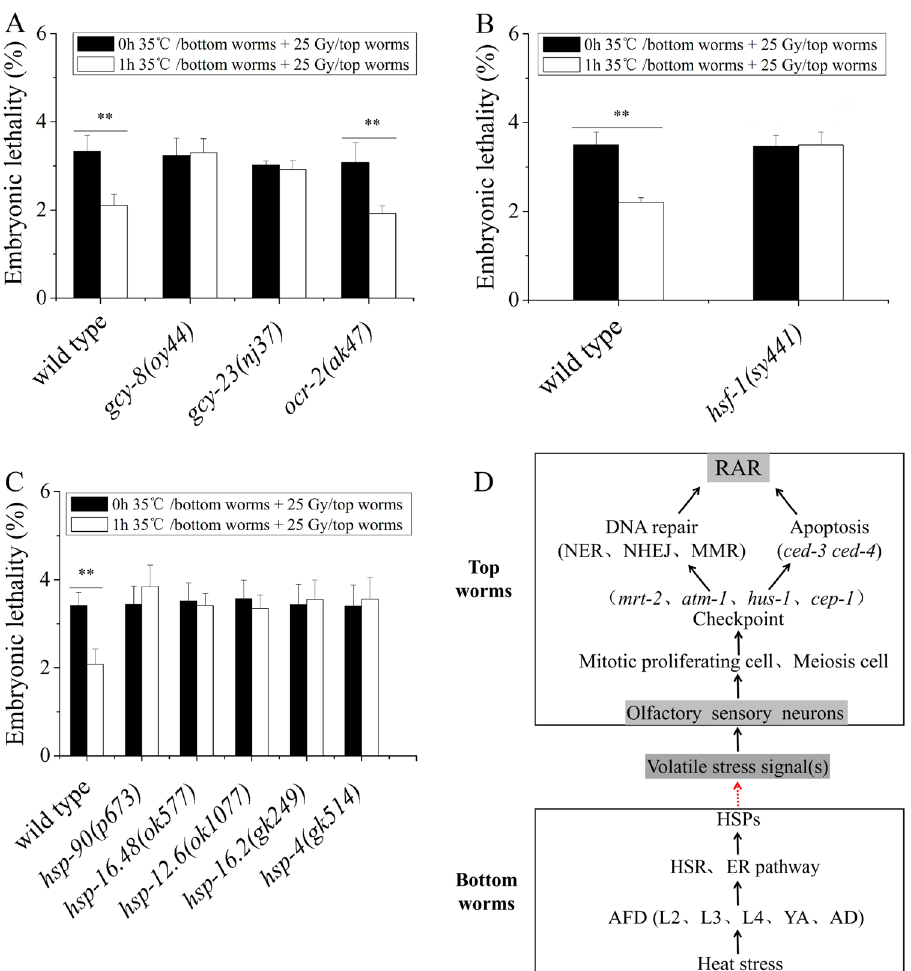
Figure 6. HSPs regulates the production of the heat-stress volatile signals in the bottom worms under heat stress. ( A – C ) Embryonic lethality of the top worms (N2) after coculture with heat-stressed bottom worms whose thermosensory neuron ( gcy-8, gcy-23 , and ocr-2 ) , hsf-1, and HSPs functions are absent; ( D ) Proposed model of production and action of heat-stress volatile signals. Bottom worms sense heat stress by AFD and activate HSF-1. HSPs activate downstream related genes to produce heat-stress volatile signals. Top worms sense volatile stress signals by olfactory sensory neurons to activate DDR pathway (checkpoint, DNA repair, apoptosis) and induce RAR in meiotic and mitotic proliferating zone of gonad. Results are means ± SD (n = 5, ** P < 0.01